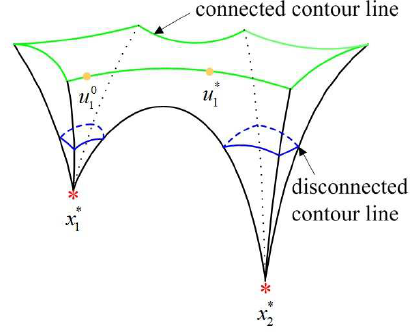
Figure 3. Connected and disconnected contour lines of the objective